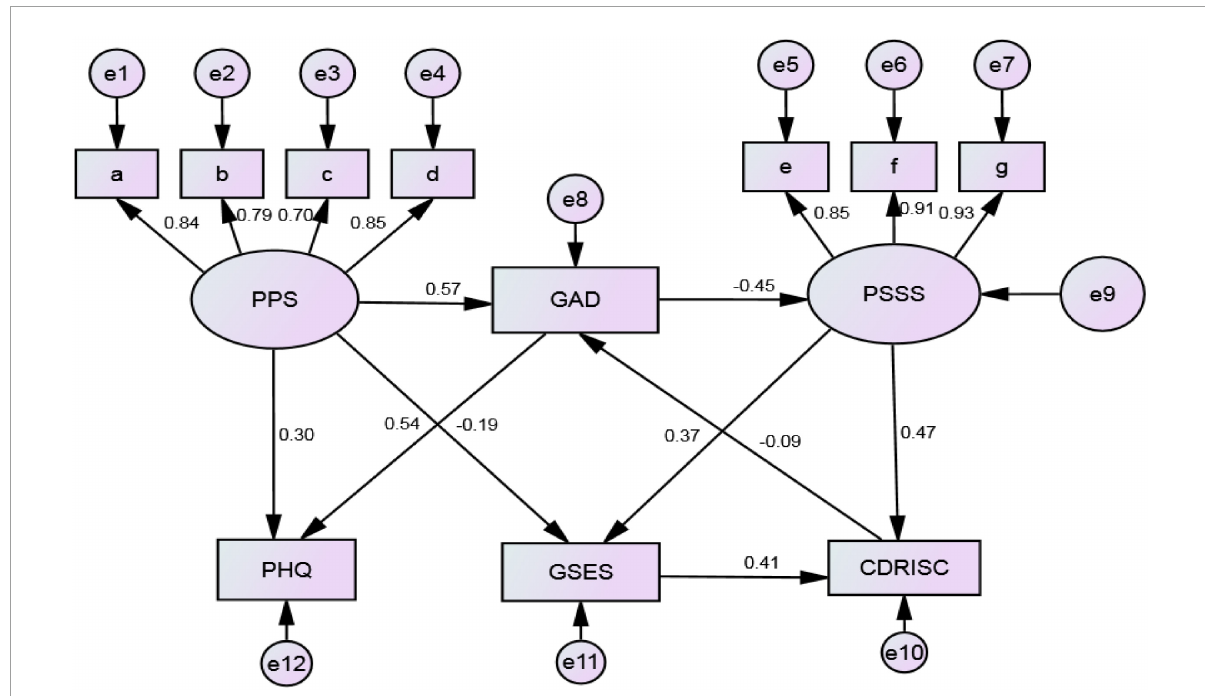
FIGURE2 Analysis of positive and negative emotional paths of the 774 pregnant women evaluated in this study. PPS, pregnancy pressure scale; GAD, generalized anxiety disorder scale; PSSS, perceived social support scale; PHQ, patient health questionnaire depression scale; GSES, general self-efficacy scale; CD-RISC, Connor–Davidson resilience scale; a, parent role; b, mother and child health; c, body shape; d, others; e, family support; f, friend support; g, others support.